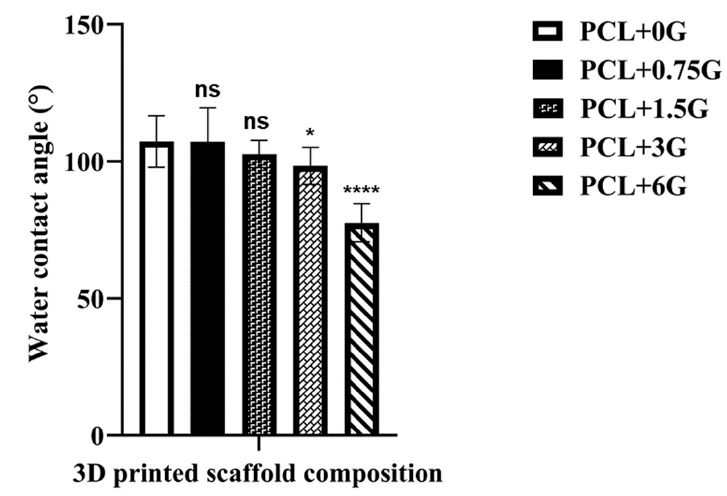
Figure 7. Mean water contact angle ( ◦ ) values for 3D-fabricated scaffolds, PCL, PCL+0.75G, PCL+1.5G, PCL+3G, and PCL+6G (see key). A 5 µ L water droplet was used on each scaffold’s upper surface, and the contact angle derived from curve-fitting using the Young/Laplace equation. Each contact angle measurement was taken on a random location on each scaffold’s upper surface and repeated on a new random location up to twelve times. Errors bars represent mean +/ − standard deviation. Statistical significance in comparison with pure PCL, as determined by Dunnett’s multiple comparisons test, is represented by either not significant (ns), where p > 0.05, or significant, where p < 0.05. Increasing significance is represented by an increasing number of asterisks (* p < 0.05 and **** p < 0.0001). The x-axis is 3D printed scaffold composition, and the y-axis is Water contact angle ( ◦